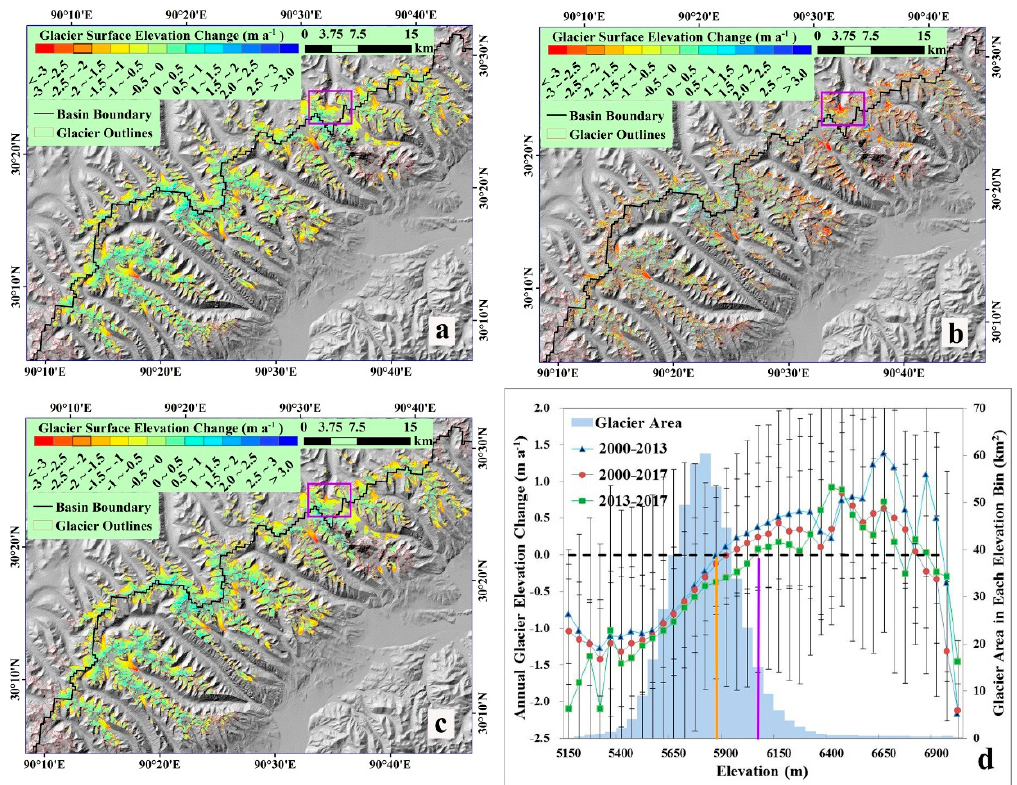
Figure 8. Annual glacier elevation changes in the WNM. ( a ): 2000–2013; ( b ): 2013–2017; ( c ): 2000–2017; ( d ): Annual glacier elevation change versus elevation (the dotted black line is the zero mass balance line, the orange and purple solid vertical lines represent the ELA lines in the 2000–2013 and 2013–2017, respectively). The purple rectangle in the images is the sample glacier described in the Figure 9.